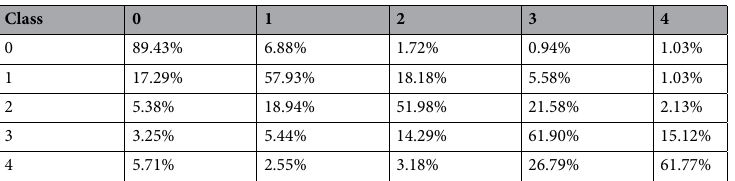
Table 8. Confusion matrix for the prediction of IsoGrouping module on the validation dataset. The diagonal values, e.g. [2, 2] represent the sensitivity for class 2. We say a feature is misclassified as class 0 when the monoisotope (first isotope) or all of the isotopes are missed, i.e., the feature is thought to be noise by mistake. The value of [2, 0] indicates what percentage of features with three isotopes are either misclassified as noise, or monoisotope is missed. [2, 1] indicates the percentage of features which have three isotopes but the third one is missed, and only the first two are combined. Similarly [2, 3] shows for what percentage of three isotope features, IsoGrouping module finds ONE additional isotope at the